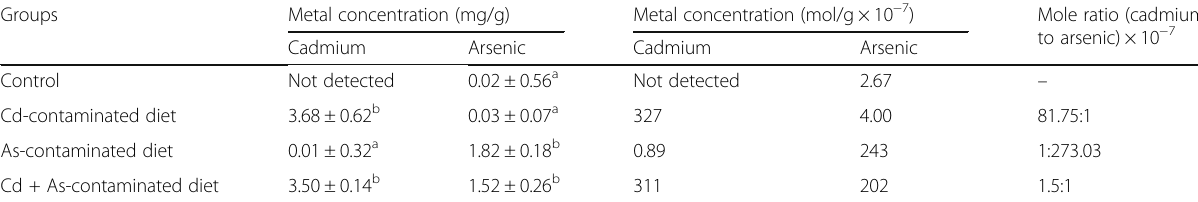
Table 2 Concentration of metals in feed given to experimental animals Groups